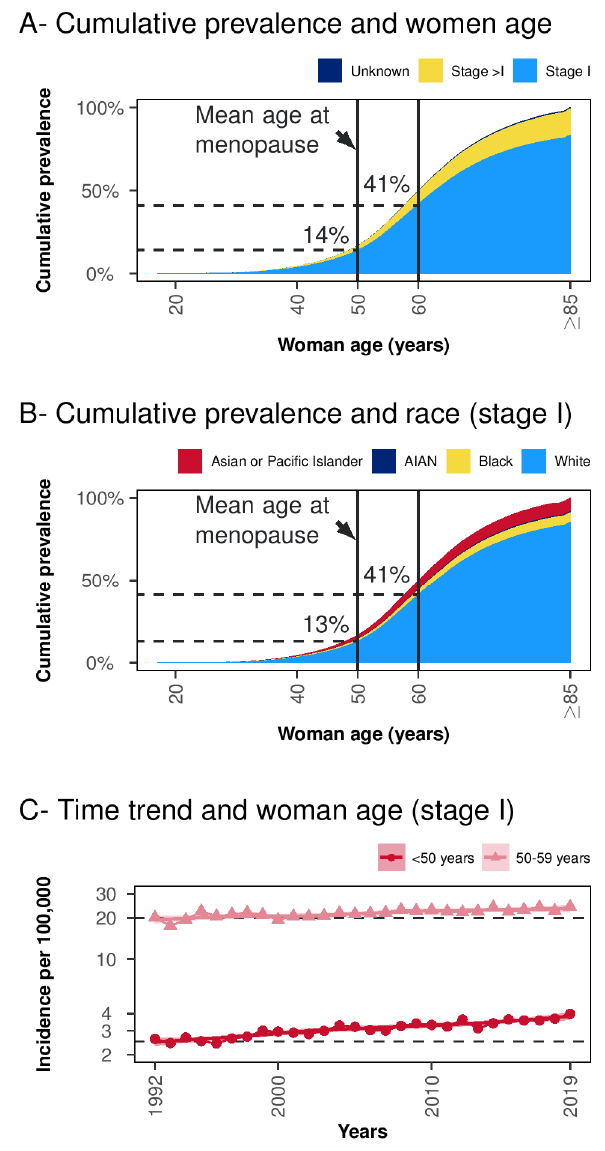
Figure 2. Cumulative women age prevalence and time-trends. Panel ( A ) Cumulative prevalence and women age-stratified per tumor stage. Panel ( B ) Cumulative prevalence and women age in tumor stage I stratified per race (cases with unknown race were excluded). Panel ( C ) Time trend in women below 50 and 50–59 years groups in SEER Research Data (12 Registries, Nov 2021 Sub, 1992–2019). Acronyms: AIAN = American Indian/Alaska Native.